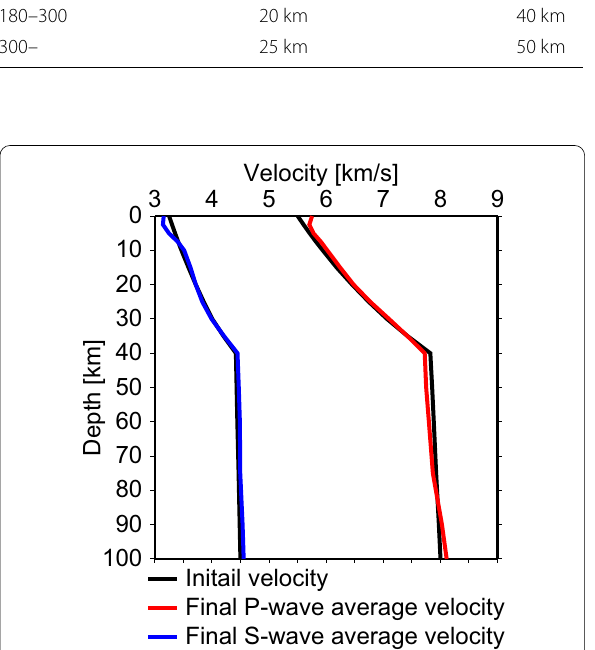
Fig. 6 Initial and average of final 3D seismic velocity